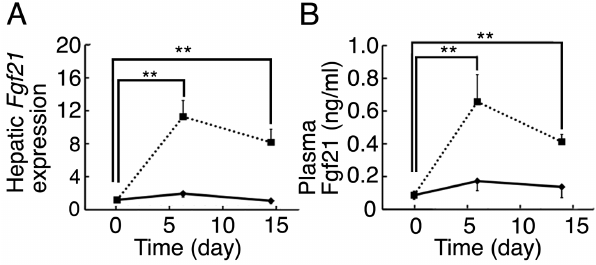
Figure 3. Hepatic Fgf21 expression and blood Fgf21 levels of mice fed KD. (A) Hepatic Fgf21 expression of 3-month-old mice fed KD for 6 days or 14 days, or NC determined by RT-qPCR (n=4–8 per group; **, P , 0.01 vs. day 0). (B) Blood Fgf21 levels of 3-month-old mice fed KD for 6 days or 14 days, or NC determined by ELISA (n=5–7 per group; **, P , 0.01 vs. day 0).